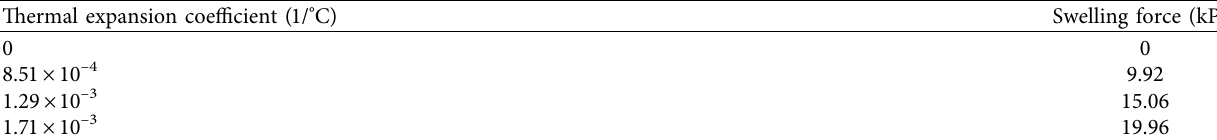
Table 3: Relationship between thermal expansion coefcient and swelling force in